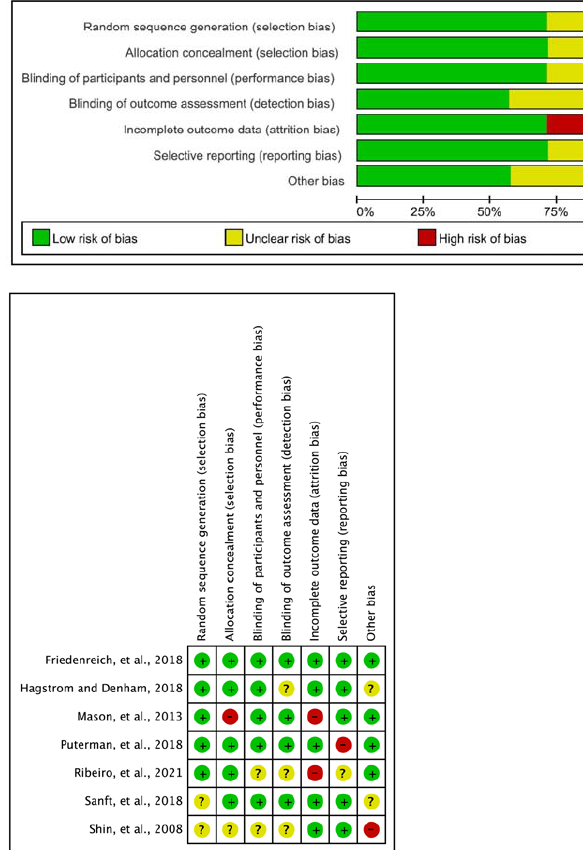
Figure 2. Risk of bias of the systematic review.